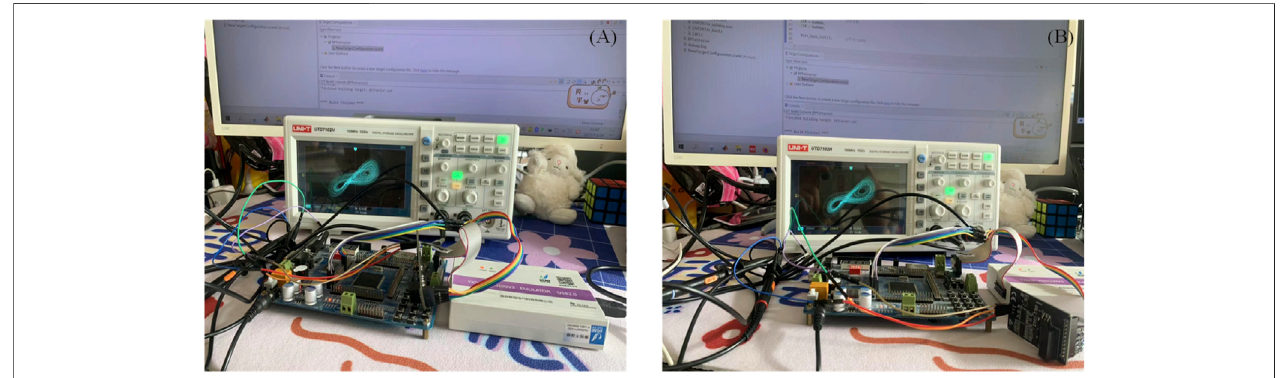
FIGURE 11 | Experimental platform for DSP